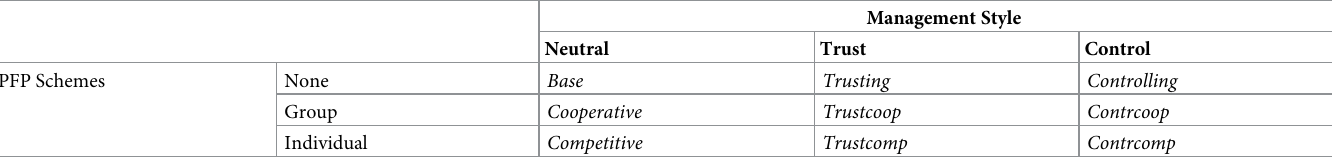
Table 3. Management style, reward schemes and